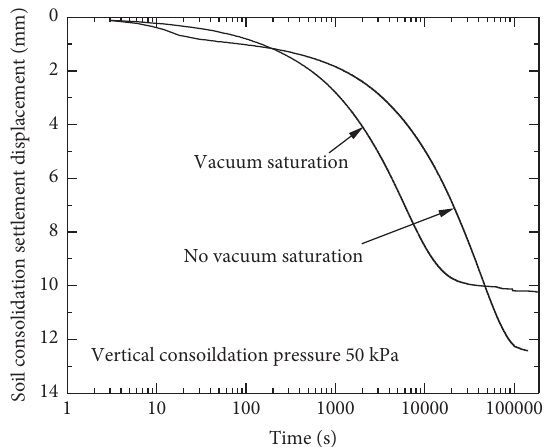
Figure 8: Bubbles generated from vacuum-saturated silt slurry.